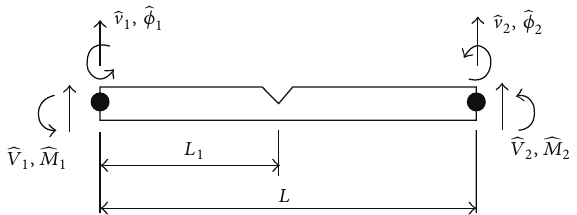
Figure 4: Two-node damaged beam spectral